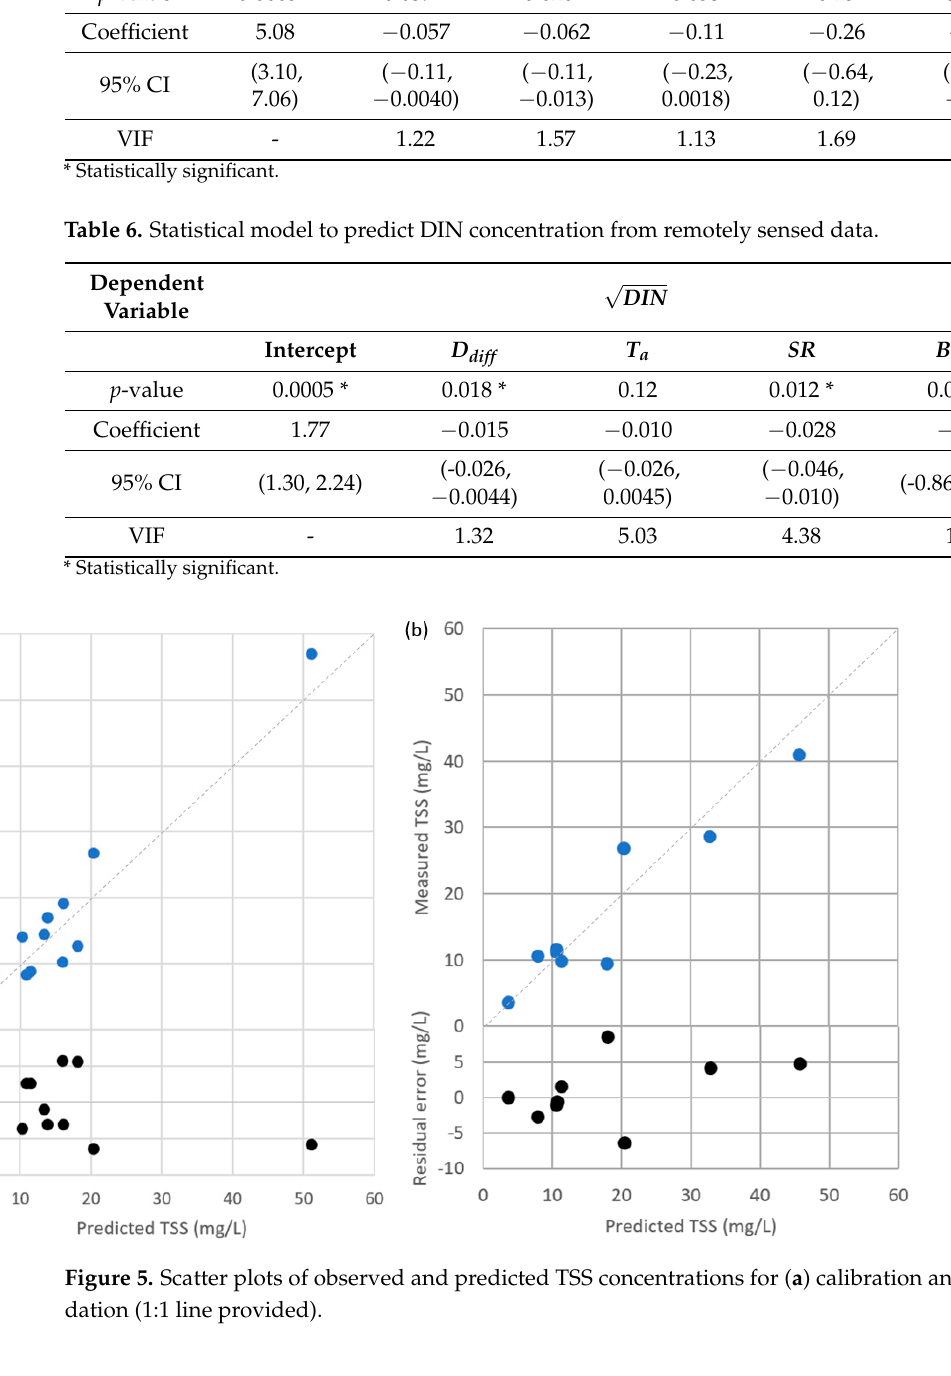
Figure 6. Scatter plots of observed and predicted DIN concentrations for ( a ) calibration and ( b ) val- idation (1:1 line provided).